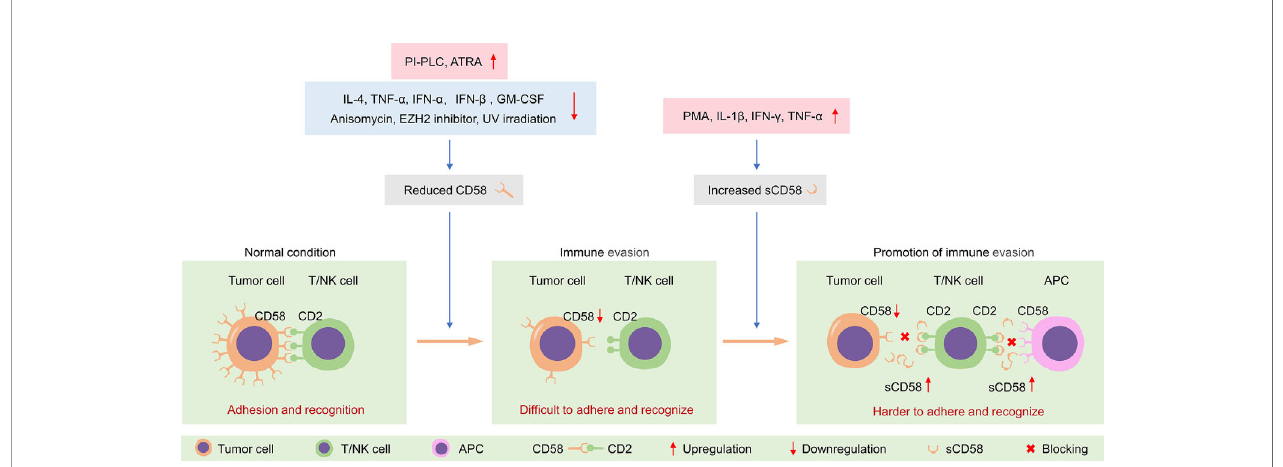
FIGURE 4 | Tumor cells evade immune surveillance by regulating the expression of CD58 on the membrane surface and sCD58 in the microenvironment. PI-PLC, phosphatidylinositol-speci fi c phospholipase C; ATRA, all-trans retinoic acid; UV, ultraviolet; PMA, phorbol-12-myristate-13-acetate; APC, antigen-presenting